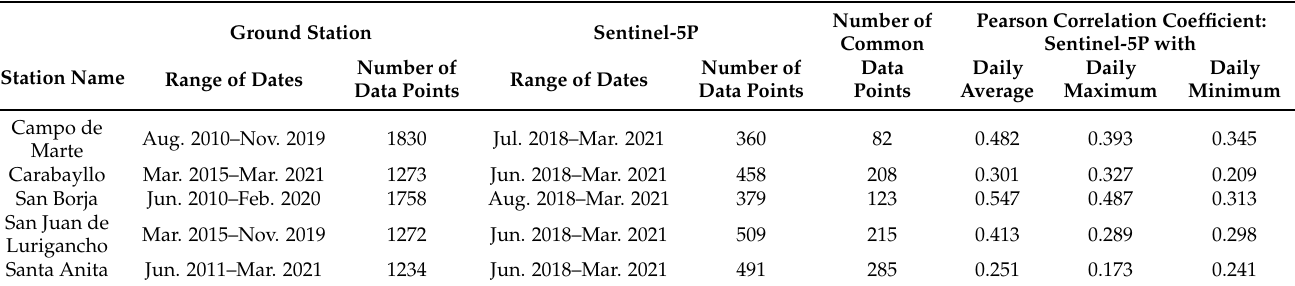
Table 2. Summary of available data for ground air quality monitoring stations and Pearson correlation coefficients with the Sentinel-5P